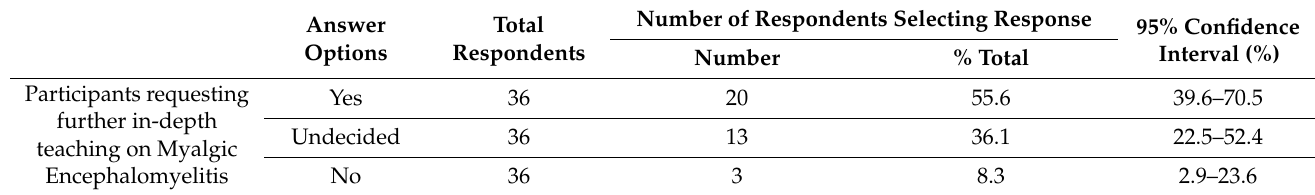
Table 11. Interest in further education on